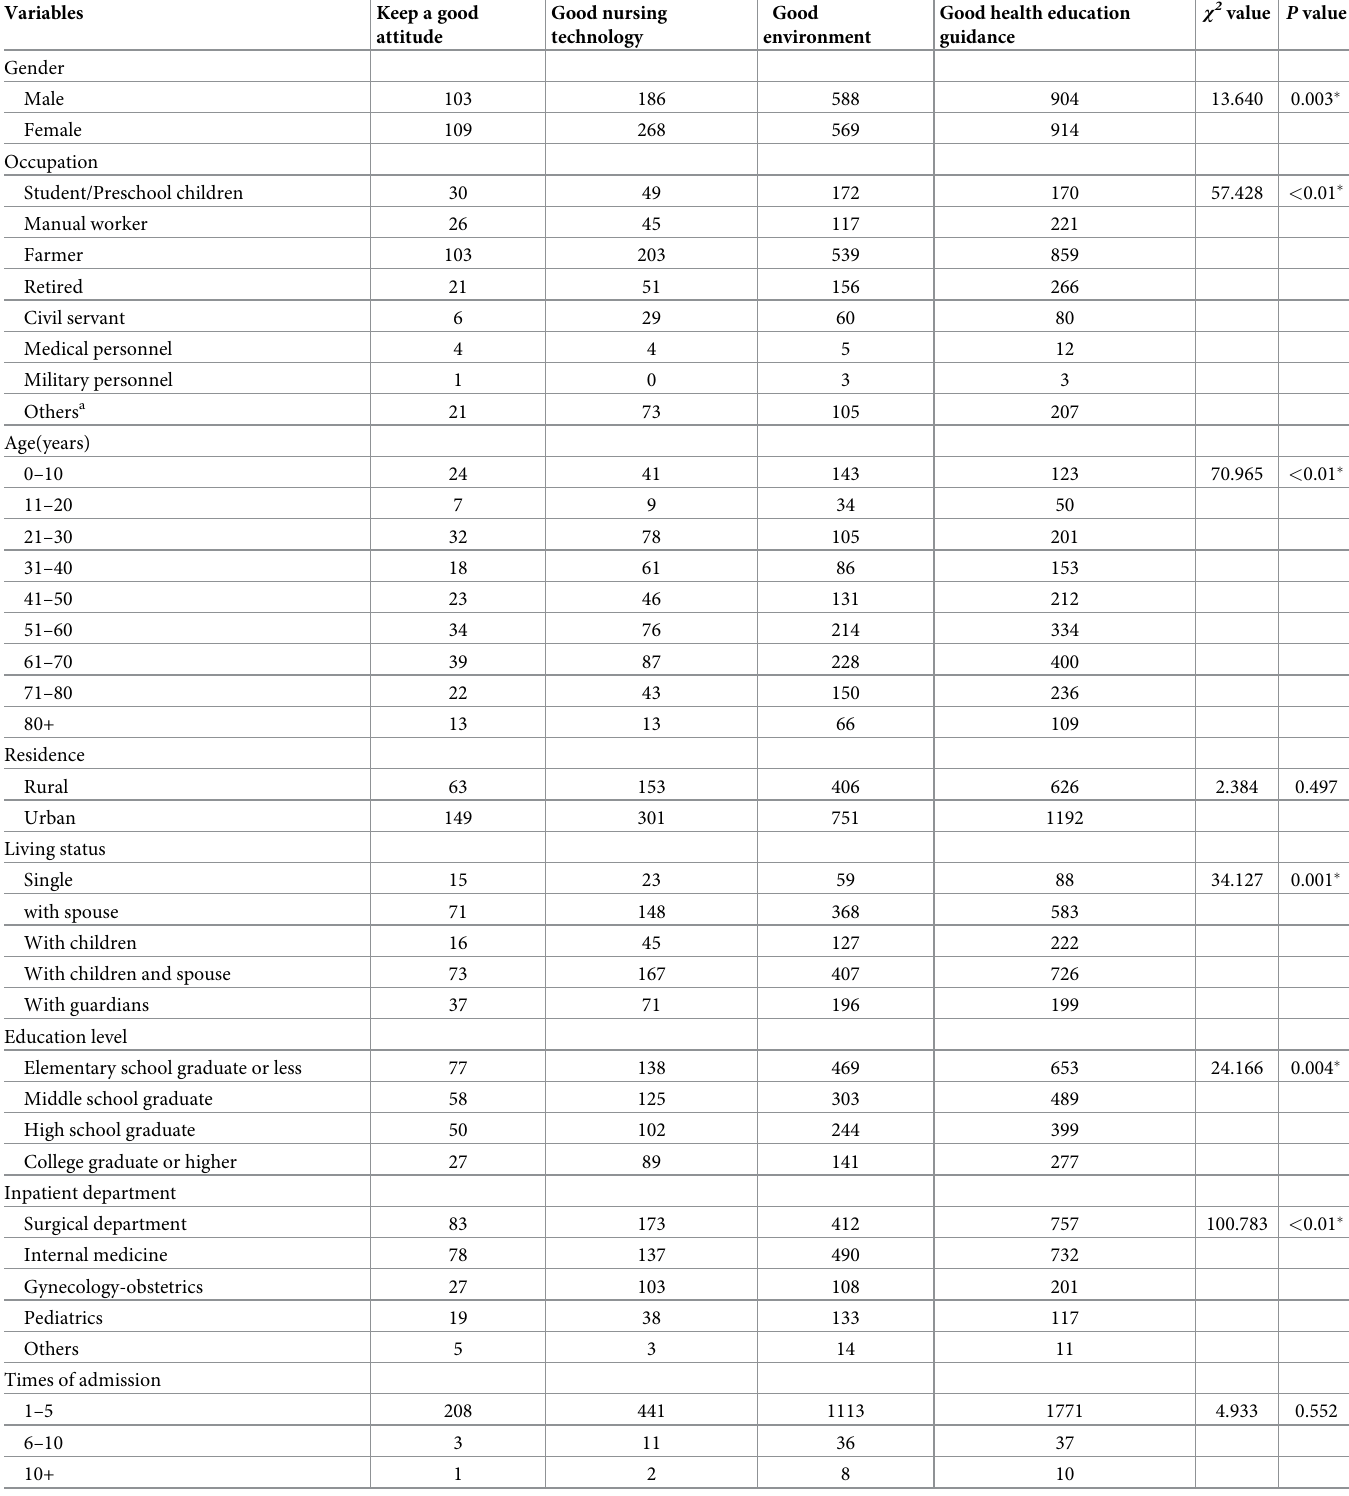
Table 1. Basic information concerning respondents’ demographic